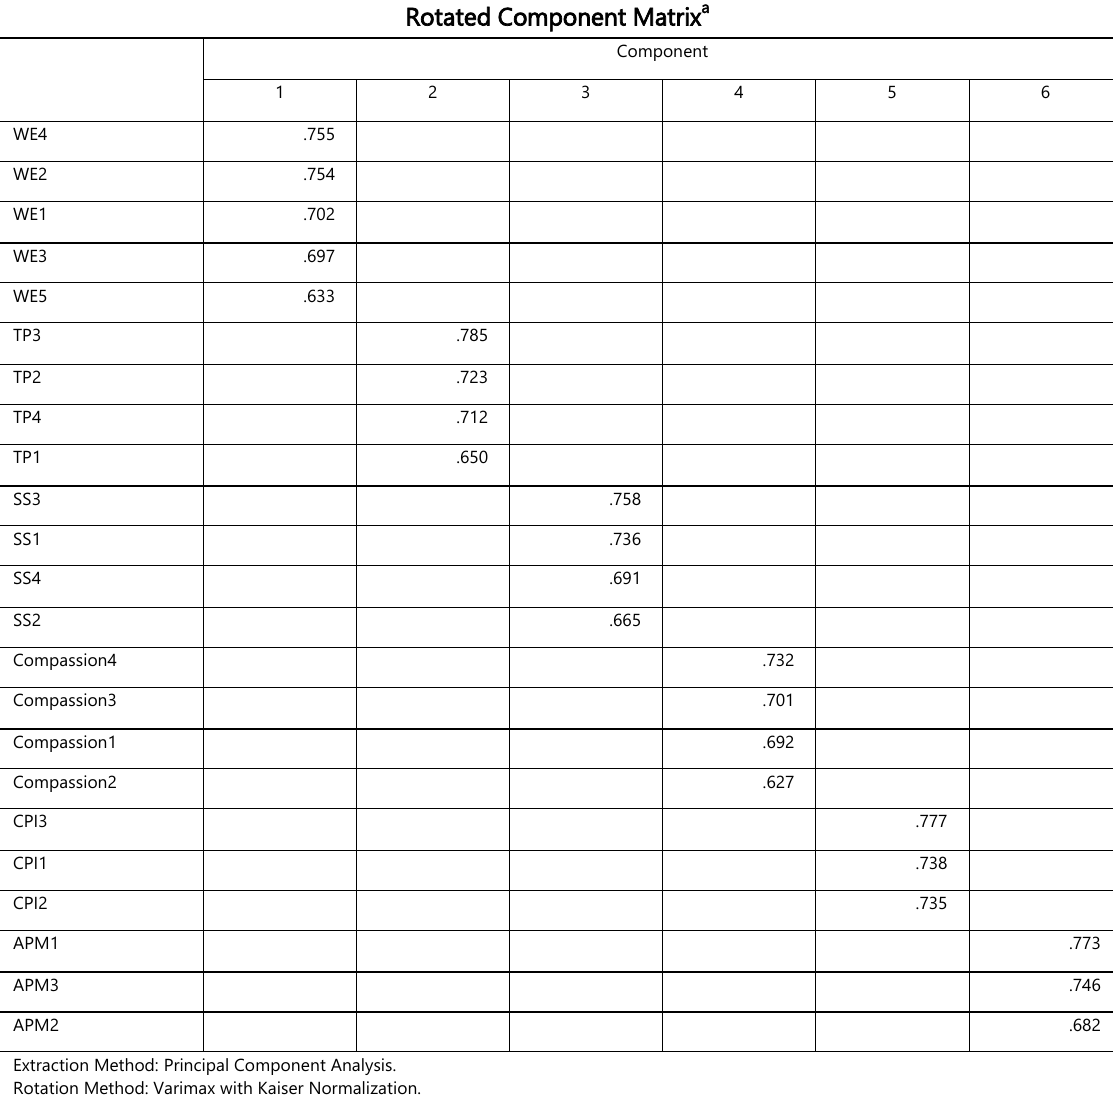
Table 3: Rotated Component Matrix (Source: Authors’ calculation) Rotated Component Matrix a